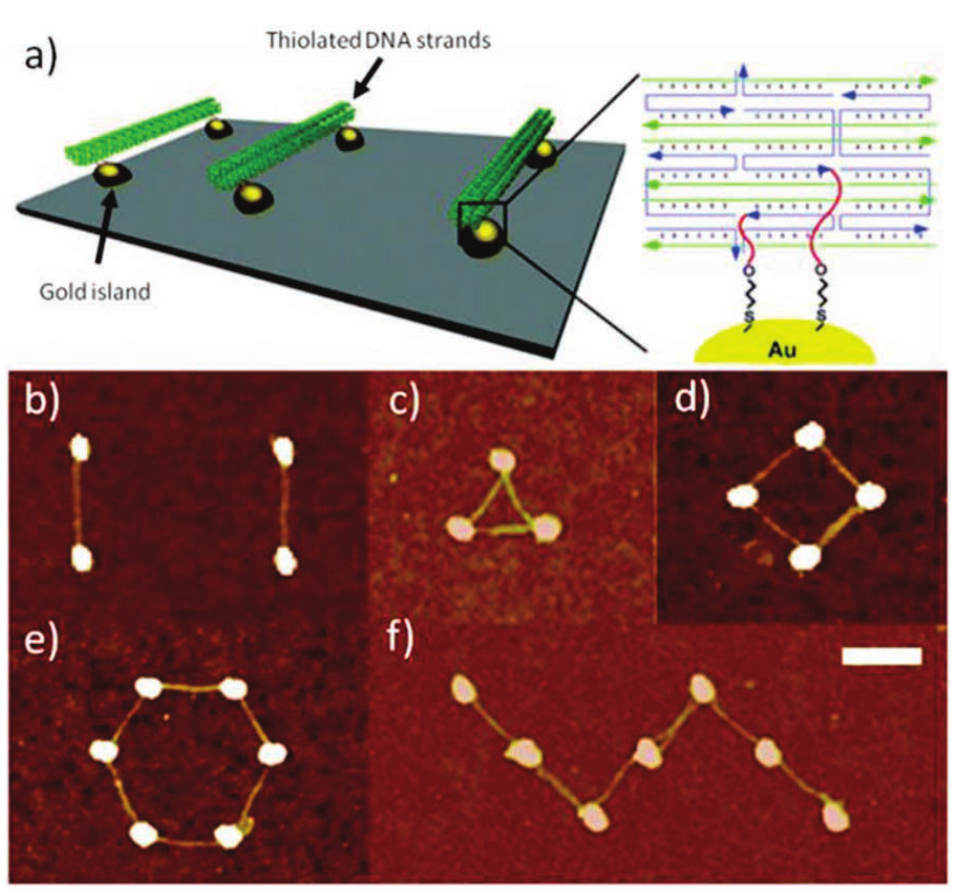
Figure 12. (a) Schematic drawing of gold islands connected by DNA origami tubes on the substrate surface. Various structures were formed by connecting gold islands with DNA origami tubes: (b) straight line, (c) triangle, (d) square, (e) hexagon, (f) “z” shape. The scale bars is 300 nm. Reprinted with permission from [61]. Copyright 2010 American Chemical Society [61].